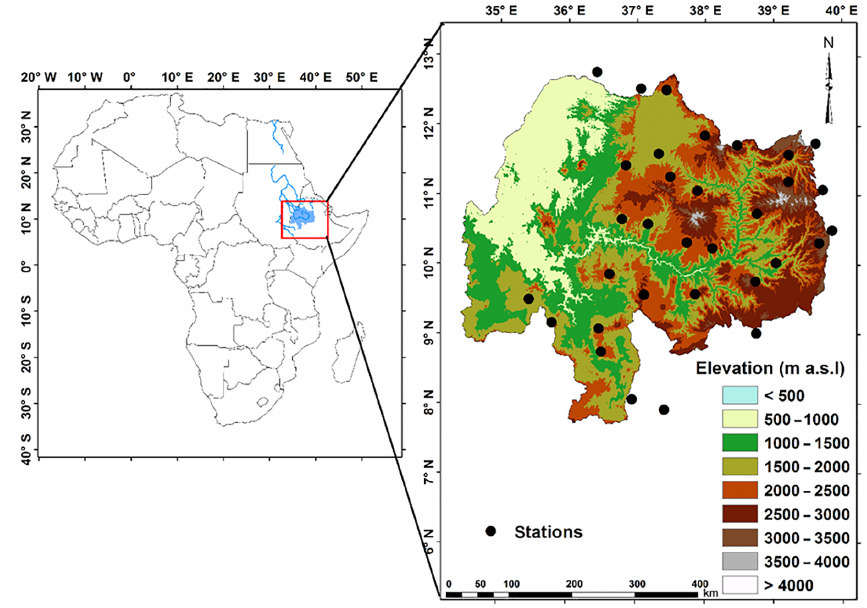
Figure 1. Elevation map of the Upper Blue Nile (UBN) basin and its location in Africa. The northeastern regions have higher elevation, while the northwestern regions have lower